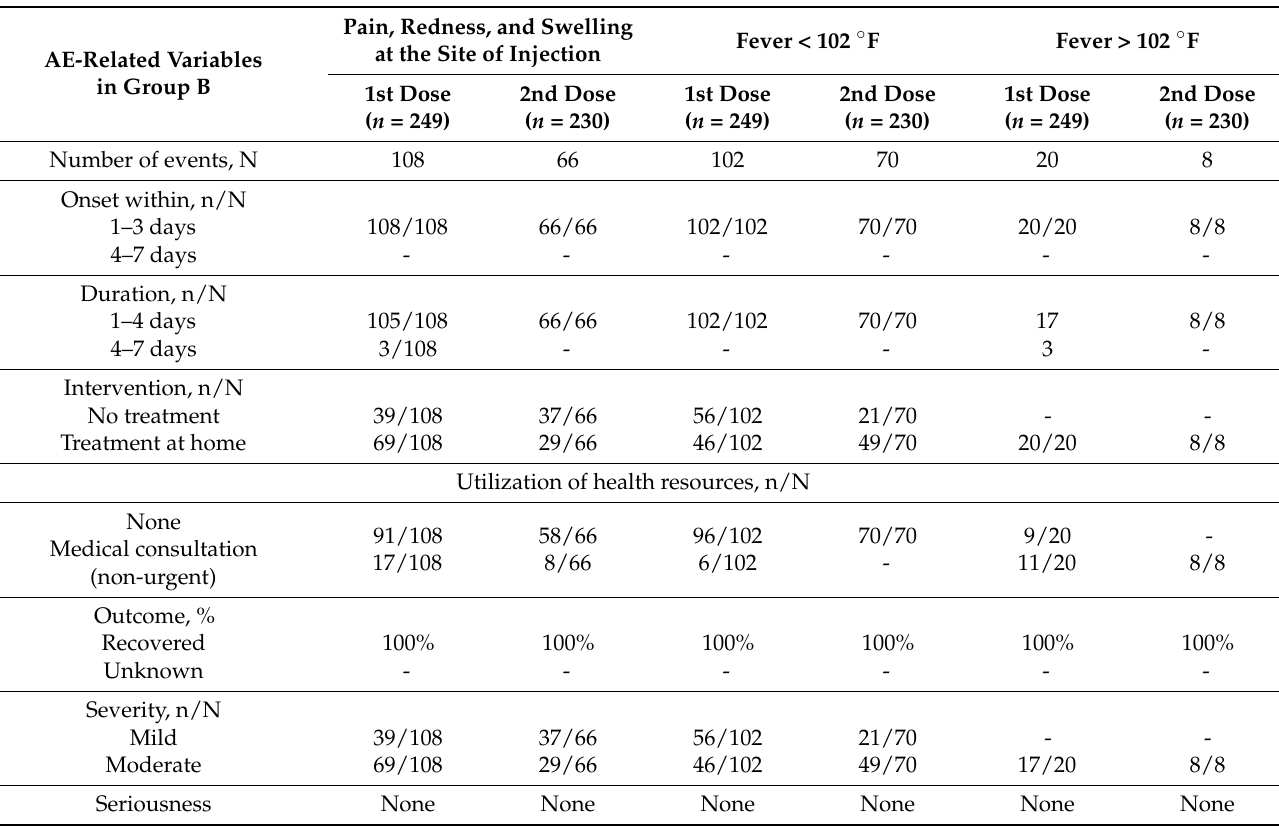
Table 5. Description of adverse event (AE)-related variables after first and second dose of m-RNA COVID-19 vaccine in group B (12–17